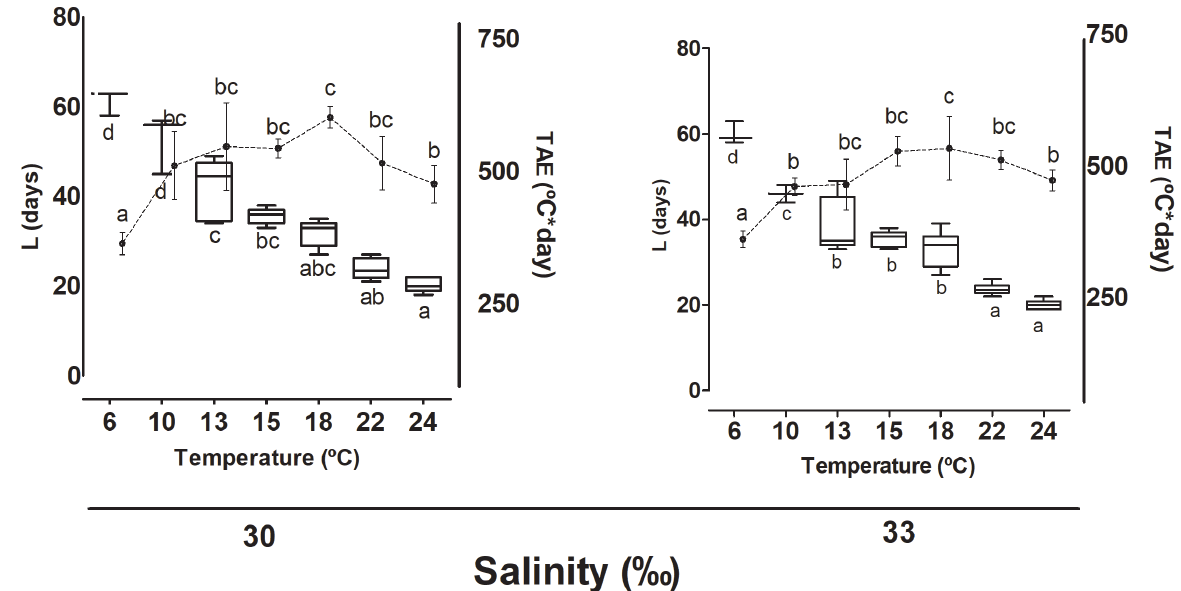
Figure 1. Length of Ovalipes trimaculatus embryogenesis (L, left Y axis) at different seawater temperature and salinity conditions and Daily Accumulated Temperature (DAT, right Y axis), representing the sum of daily average temperatures (°C) from fecundation to hatching. Different letters indicate significant statistical differences between means using Tuckey tests. Central mark in box plots represent the mean value; upper and lower box extremes show the inter-quartile range of observed values; whiskers show maximum and minimum observed